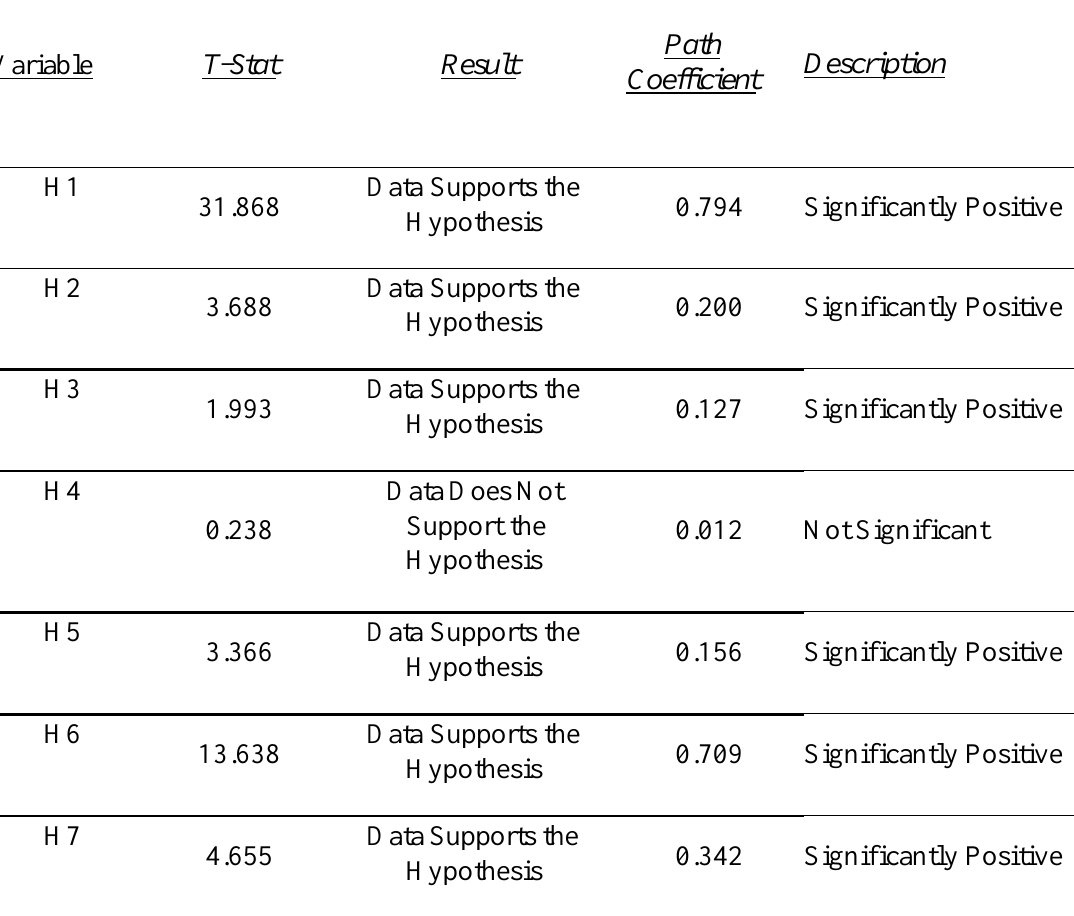
Table 1. Hypothesis